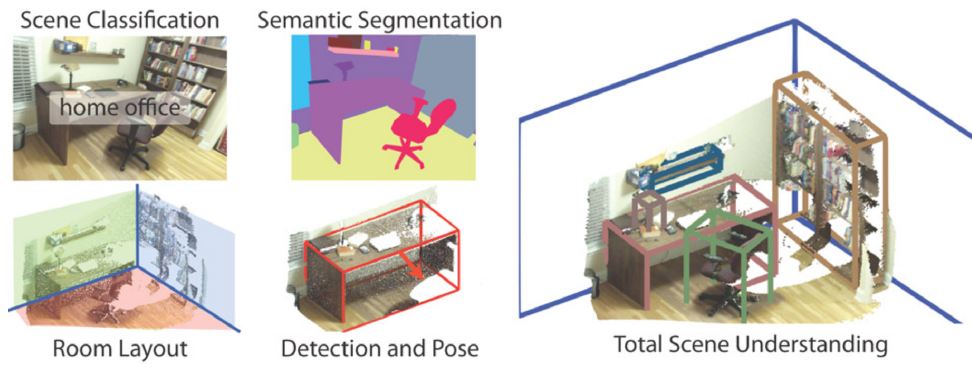
Figure 7. SUN RGB-D Dataset